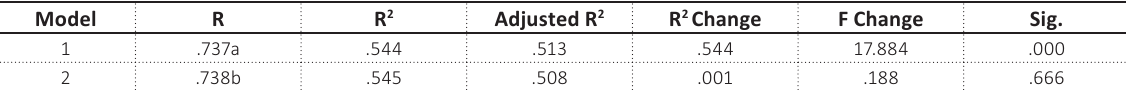
Table 4. Influence of Maslow’s hierarchy of needs on mumpreneurial intentions (marital status) Model